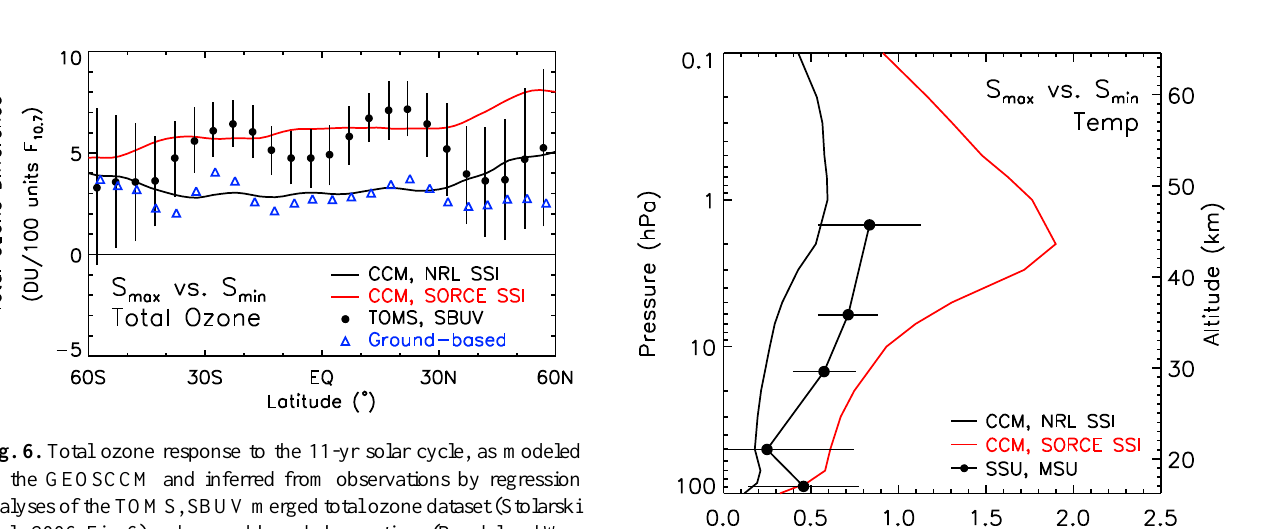
Fig. 5. Simulated ozone solar cycle response in the GEOSCCM, similar to Fig. 4 but in altitude-latitude cross section, using (a) NRL and (b) SORCE SSI. The colored (non-white) portions of the plots indicate regions where the ozone response is statistically significant at the 95% confidence level.